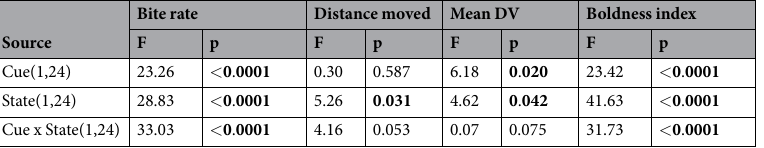
Table 2. Comparison of behavioural variables for juvenile Ambon damselfish that were placed onto a dead coral patch and tested for a response to either seawater or conspecific alarm odours (Cue), and then transferred to a live coral patch and tested again for their response to the same cue. ‘State’ is a repeated measures variable that accounts for any change in behaviour of individuals as they are transferred between the two coral health states. Degrees of freedom are given in